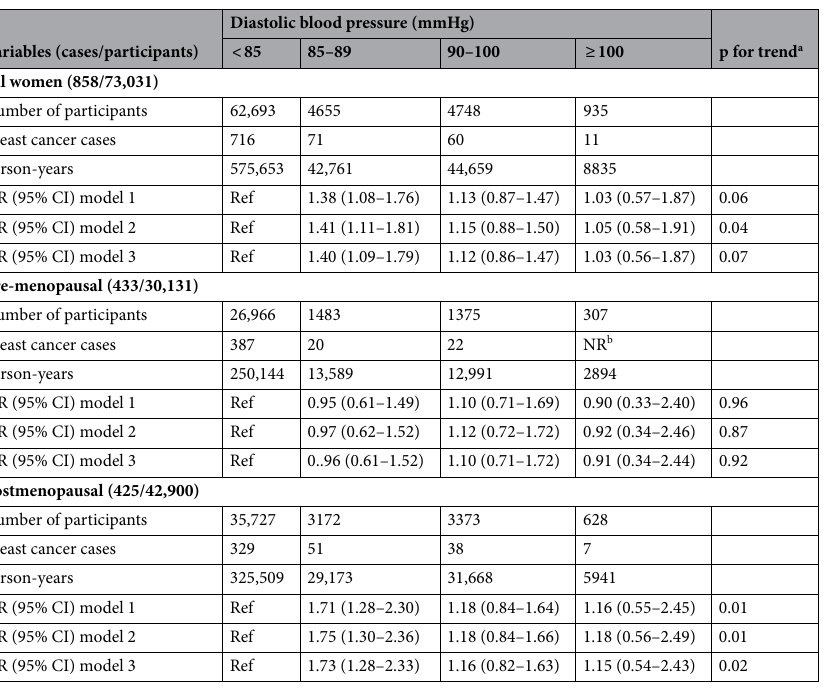
Table 2. Hazard ratios and 95% confidence intervals of breast cancer risk according to International Society of Hypertension classification of diastolic blood pressure (mmHg). Model 1: unadjusted. Model 2: adjusted for family history of breast cancer, body mass index, parity, age at birth of a first child, age at menopause, breastfeeding, physical activity, alcohol consumption, smoking status. In postmenopausal additionally adjusted by hormone replaced therapy use. Model 3: adjusted for model 2 variables and self-reported history of hypertension. a p-trend values were calculated with linear-by-linear association tests. b Frequencies less than 5 are not